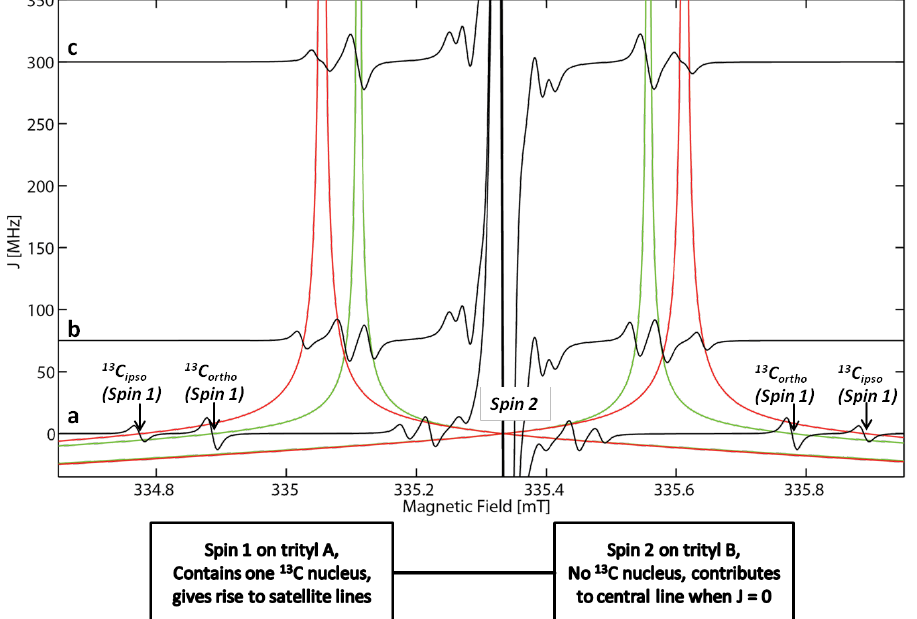
Figure 2. Simulated cw EPR spectra of a bis-trityl compound using typical parameters. The satellite lines stemming from the i - and o - 13 C nuclei are indicated by arrows and have hyperfine coupling constants of 31.25 and 25.00 MHz, respectively. The central line stems from electron spins centered on trityl groups that do not contain any 13 C nuclei. The central line also includes the isotopomers that do not contain any 13 C nuclei on either trityl group. The green and red lines indicate how the resonance fields of these satellite lines shift in dependence of the J value used in the simulation (spectrum a : J = 0 MHz; spectrum b : J = 75 MHz; spectrum c : J = 300 MHz). The resonance fields of the other satellites have been omitted for clarity.